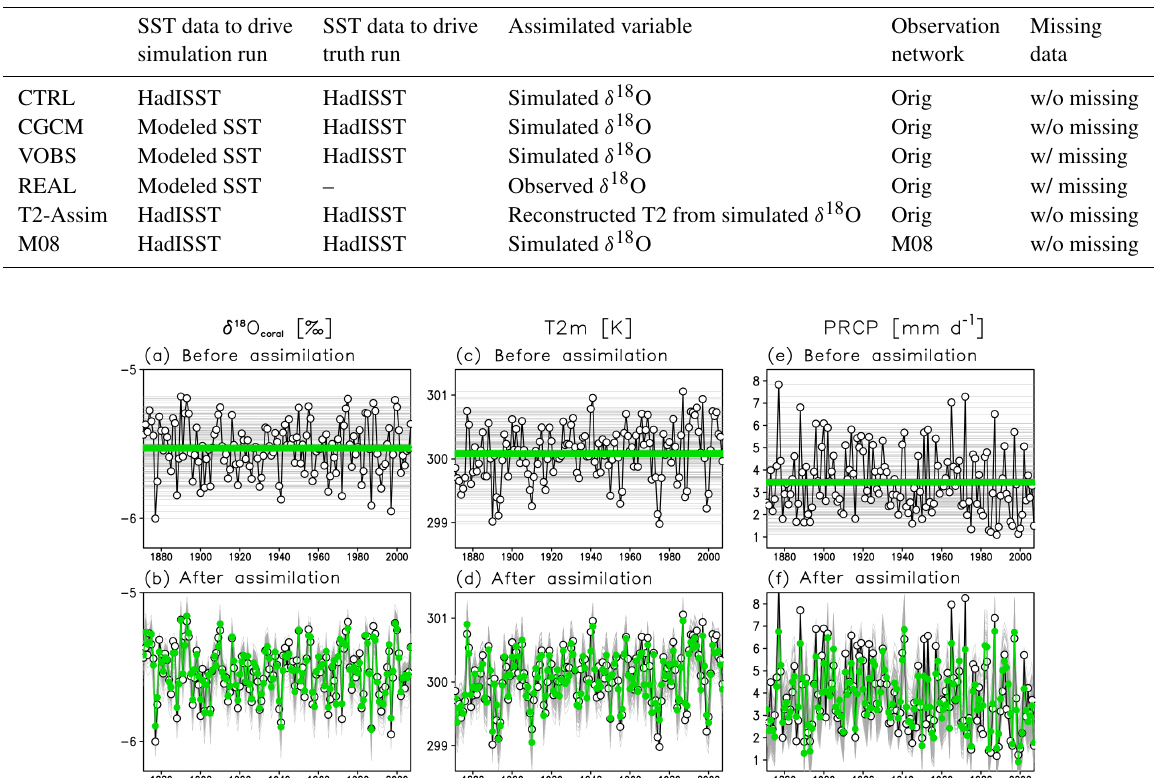
Figure 2. Annual mean δ 18 O in corals at a location where observational data were available (1 ◦ N, 157 ◦ W) for (a) background and (b) anal- ysis. The black line indicates the truth, gray lines indicate ensemble members, and green line indicates the ensemble